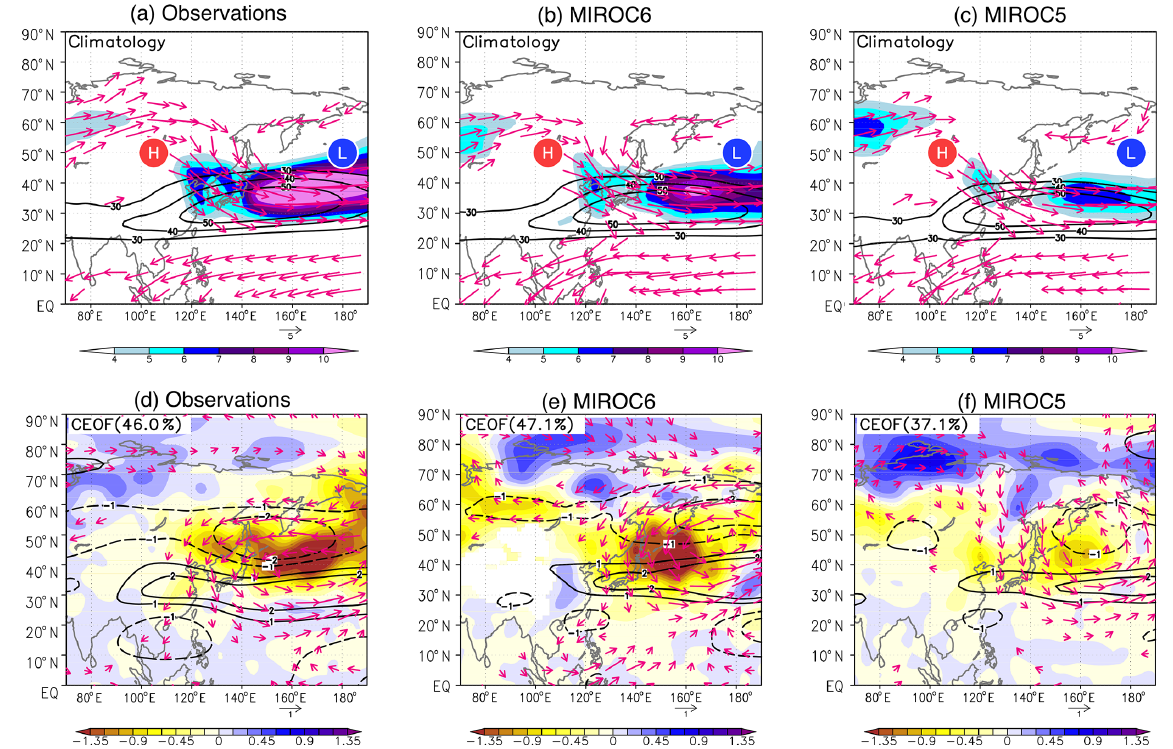
Figure 22. (a–c) Wintertime (DJF) climatology of STA (colors; Kms − 1 ), the 300hPa zonal wind (contour; ms − 1 ), and the 300hPa hor- izontal wind (vector; ms − 1 ) for (a) observations (ERA-I), (b) MIROC6, and (c) MIROC5. (d–f) As in (a–c) , but for anomalies regressed onto the time series of the EOF1 of the 850hPa meridional wind over [120–150 ◦ E, 30–60 ◦ N].